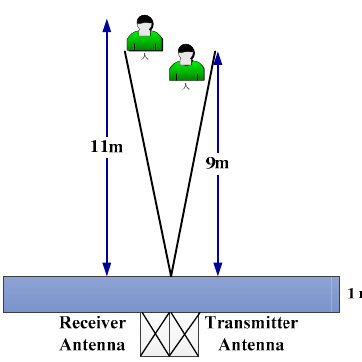
Figure 4. The conducted two-target detection experiments.